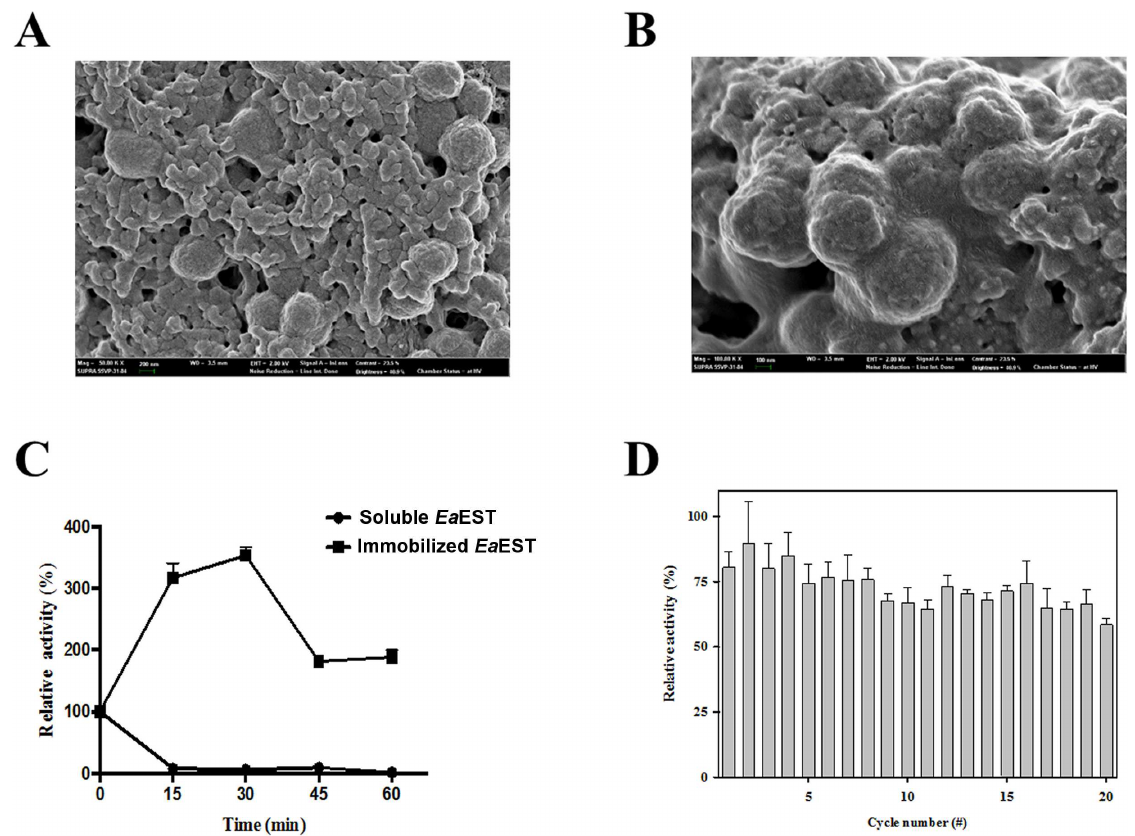
Fig 10. Immobilization of Ea EST. Scanningelectronmicroscope(SEM) imageof cross-linked enzyme aggregates( Ea EST- CLEAs). Representativeimagesat 50 kX (A) and100kX (B) areshown.(C) Thermostabilityof immobilized Ea EST( ■ )andsoluble Ea EST( ● )at 80˚C. Activity was measured every 15 min. (D) Reusabilityof immobilized Ea ESTwascomparedto thesolubleenzyme for 20 reactioncycles. Residualactivitieswereexpressedrelativeto those of free Sm23 (100%).